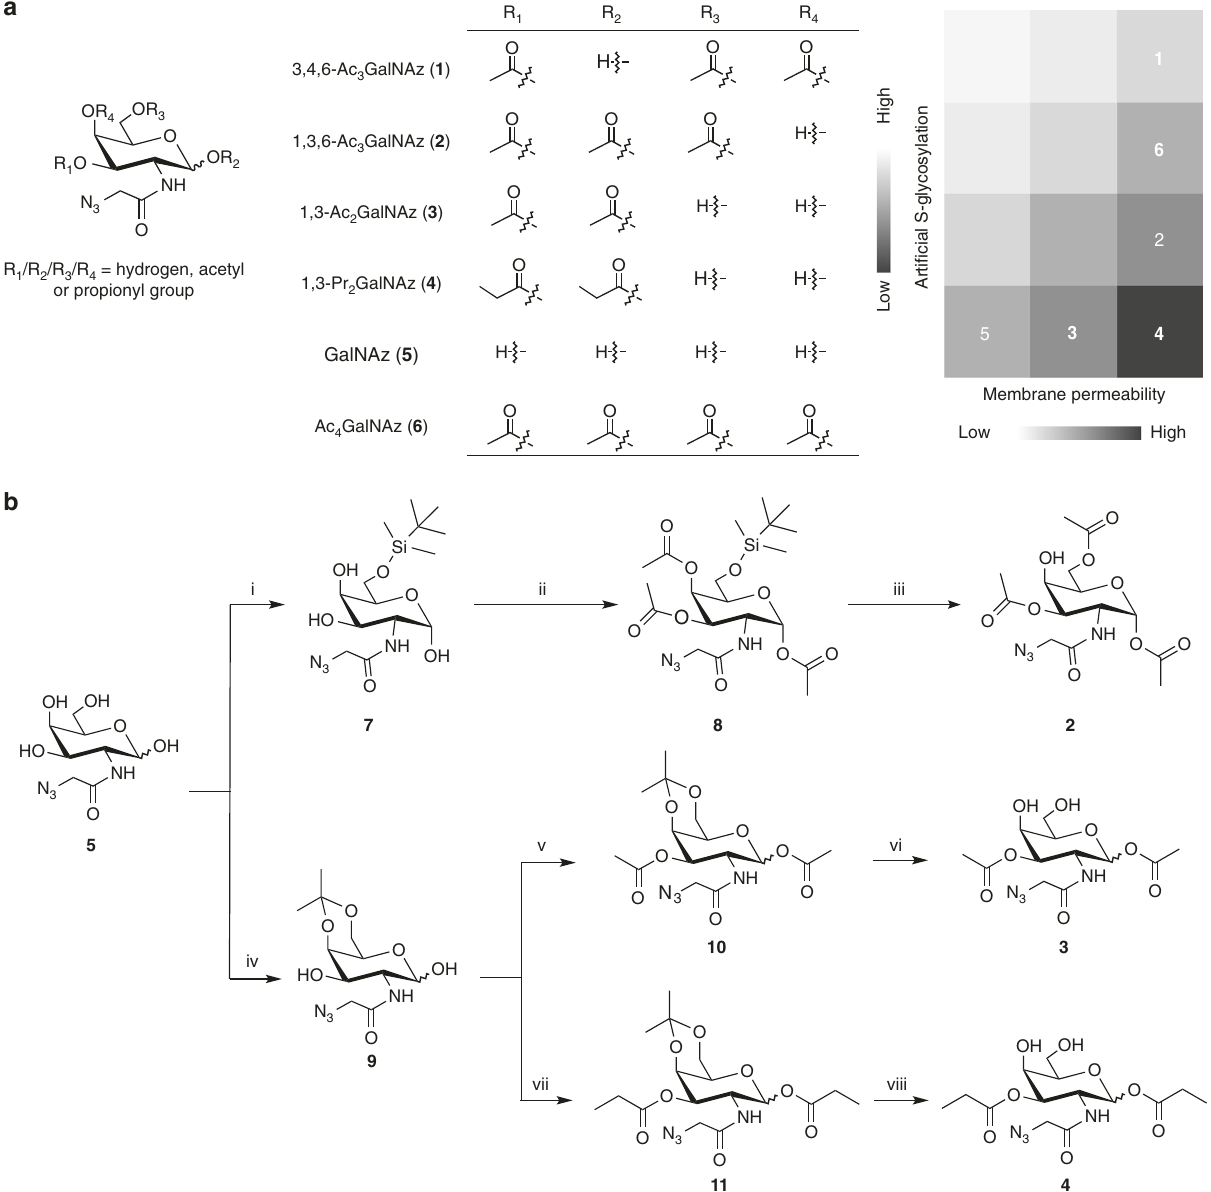
Fig. 1 Design and synthesis of partially esteri fi ed GalNAz. a Partially protected GalNAz with varied numbers of acetate or propionate. The greyscale chart shows the membrane permeability and ability of inducing arti fi cial S-glycosylation of the unnatural monosaccharides. b Chemical synthesis of 2 , 3 and 4 . i. tert-butyldimethylsilyl chloride, pyridine, room temperature (R.T.), 20 h, 50%. ii. acetic anhydride, pyridine, 0 °C-R.T., overnight, 92%. iii. tri fl uoroacetic acid, dichloromethane, 0 °C-R.T., 1 h, 39%. iv. 2,2-dimethoxypropane, (±)-camphorsulfonic acid, acetone, 0 – 4 °C, 1 h, 48%. v. acetic anhydride, pyridine, 0 °C-R.T., overnight, 80%. vi. tri fl uoroacetic acid, H 2 O, CH 3 CN, 0 °C-R.T., 1 h, 70%. vii. propionic anhydride, pyridine, 0 °C-R.T., overnight, 82%.